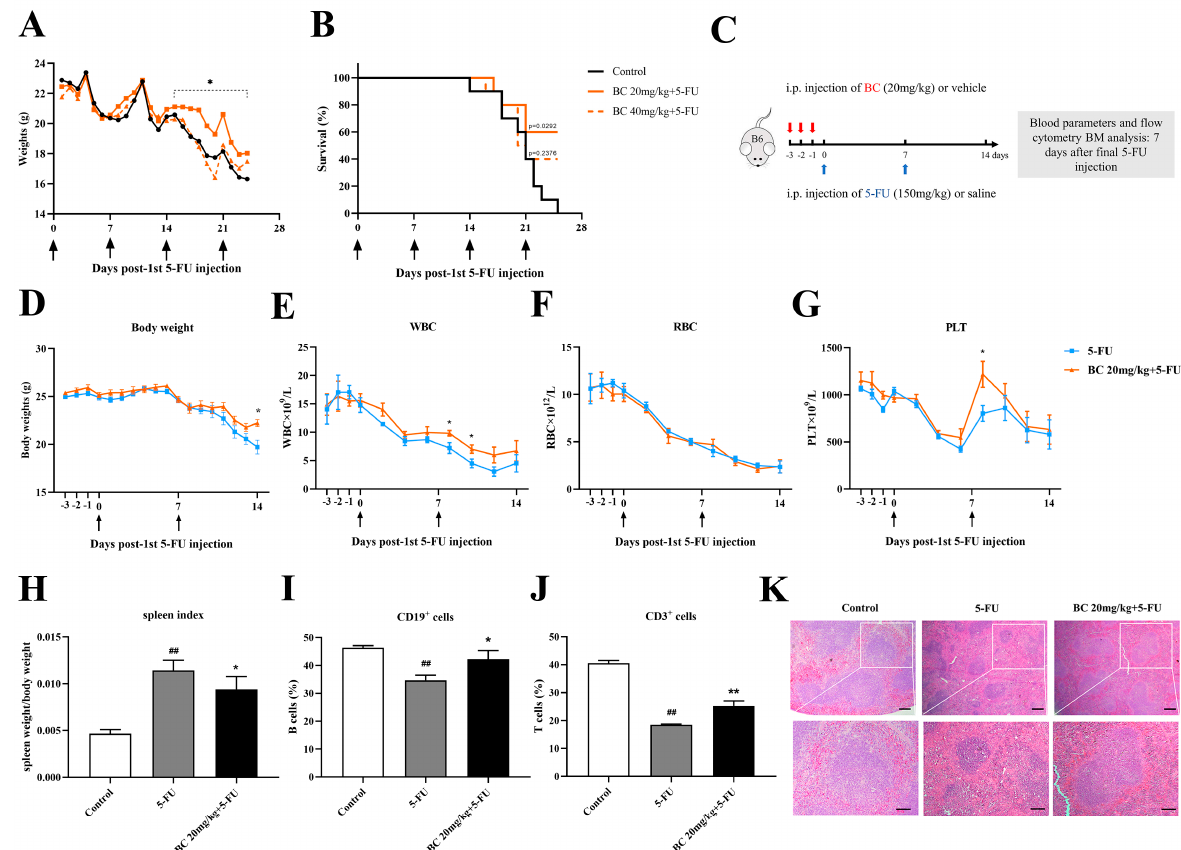
Figure 6. BC pretreatment enhances survival and ameliorates myelosuppression in mice with cycles of 5 − FU injection. ( A , B ) Body weight and survival of mice that were i.p. injected with vehicle or BC (20 or 40 mg/kg) for 3 days (once a day) before being repeatedly injected with 5 − FU (150 mg/kg) once a week ( n = 10). Arrows indicate the time points of injection of 5-FU. ( C ) Experimental schematic of evaluating the effects of BC pretreatment on 5 − FU − injured bone marrow in mice. B6 represents C57BL/6 mice. Red arrows indicate BC injection timepoints. ( D ) Mouse body weights ( n = 5). ( E − G ) WBC ( E ), RBC ( F ) and PLT counts ( G ) of mouse peripheral blood measured every 2 days ( n = 5). Arrows indicate the time points of injection of 5-FU. ( H − J ) Mouse spleen index ( H ) and flowcytometry analysis of the CD19 + ( I ) and CD3 + cells ( J ) in mouse spleen ( n = 5). Spleens were removed at day 7 after the second cycle of 5 − FU injection. ( K ) Histopathological analysis of spleen tissue by HE staining. Scale bars: 200 µ m (upper panel) and 100 µ m (lower panel). All data are shown as mean ± SEM. ## p < 0.01, compared with control group. * p < 0.05, ** p < 0.01, compared with 5-FU group (Student’s t test).